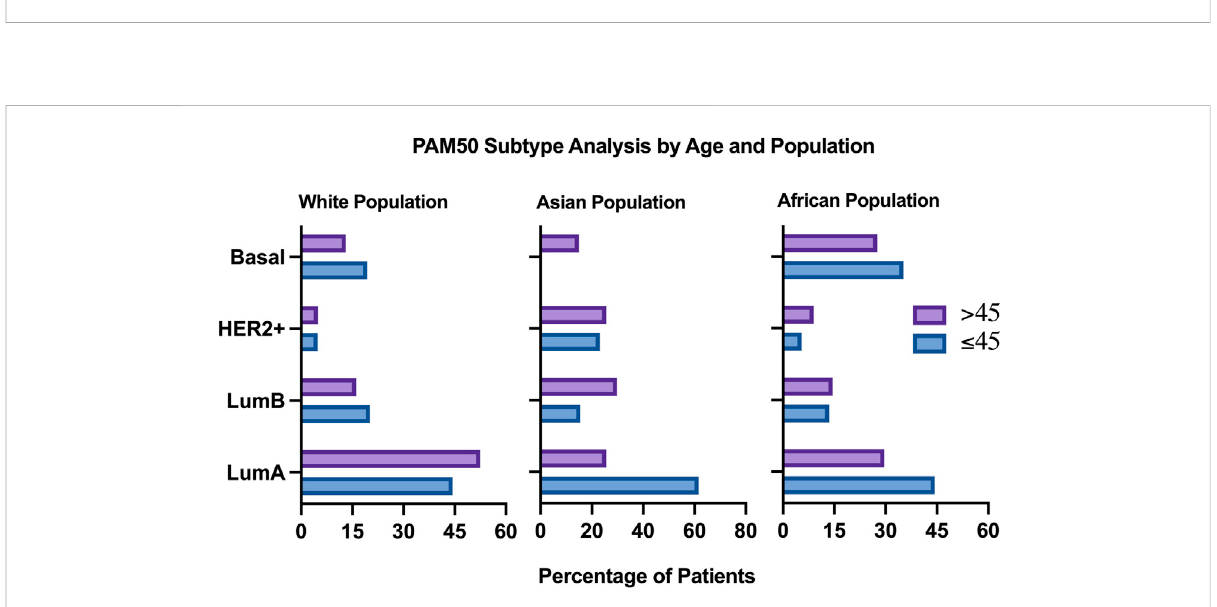
FIGURE 7 Clinical plot of PAM50 breast cancer subtypes in two different age groups, All